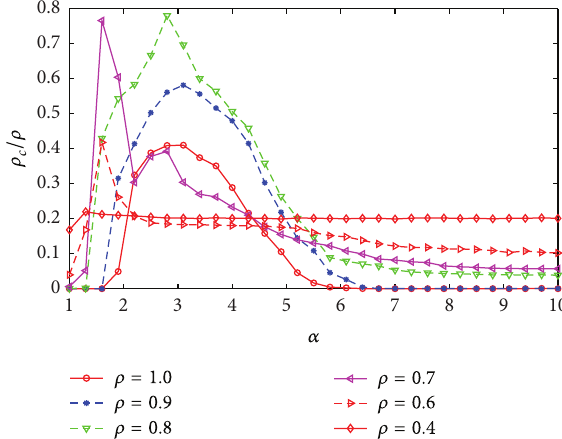
Figure 5: Relative density of cooperators 𝜌 𝑐 /𝜌 in dependence on the fraction of A players 𝜇 for different values of 𝜌 when 𝑏 = 1.15 and 𝛼 = 3.0 (see legend). Depending on the region of 𝜌 , the optimum values 𝜇 that maximize the fraction of cooperators are different: for a larger occupation fraction, there are two maximum values. For example, two maximum values approximately occur at 𝜇 = 0.28 and 0.72 when 𝜌 = 0.9 , respectively. However, for a smaller occupation fraction, for example, 𝜌 = 0.8 or 0.7, there is only one maximum value that approximately occurs at 𝜇 = 0.5 .